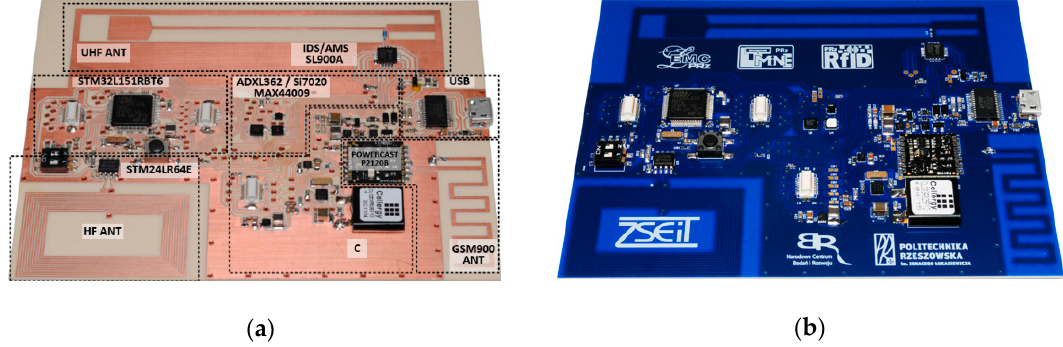
Figure 2. Demo boards of autonomous RFID sensor: ( a ) Test version manufactured in authors’ scientific HYBRID Laboratory; ( b ) Production version manufactured in ELMAK Ltd Company (Rzeszów, Poland).